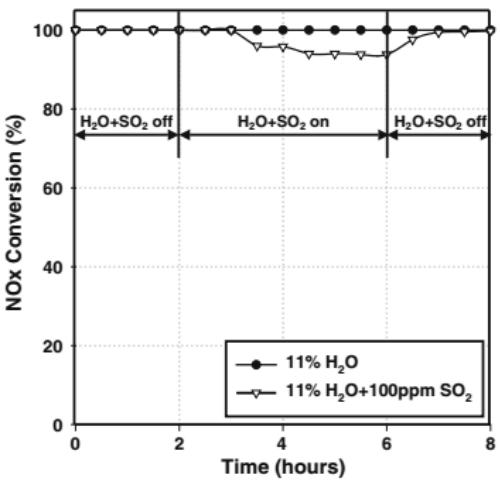
Figure 3. The effects of H 2 O and SO 2 on NO x conversions over MnO x ‐ SC catalyst at 120 °C. Reactants: 500 ppm NO, 500 ppm NH 3 , 5 vol % O 2 in N 2 . The gas hourly space velocity (GHSV) was 50,000 h − 1 . (Reproduced with permission from Reference [23], Copyright 2006, Springer.).